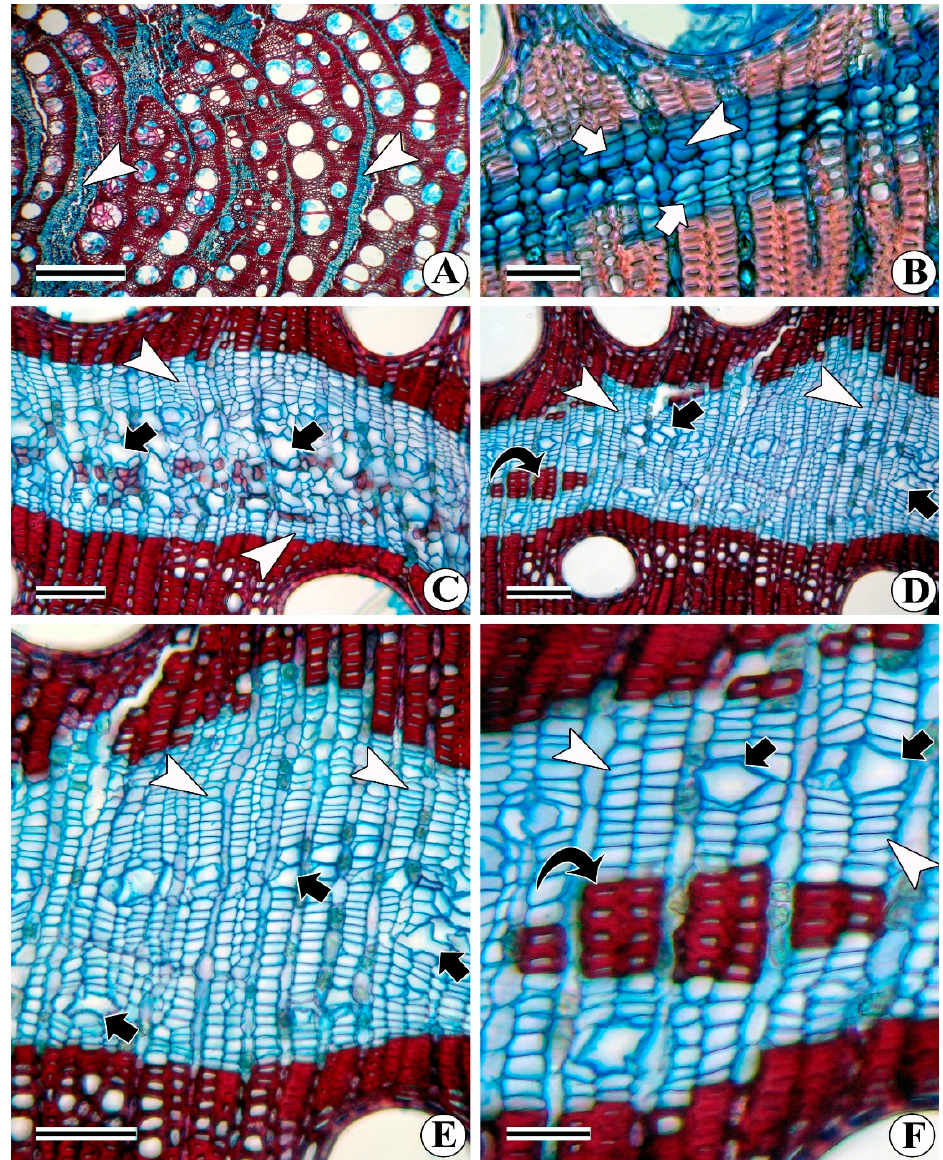
Figure 7. Transverse view of Dalechampia stems showing various stages of interxylary phloem development. ( A ) A mature stem showing tangential bands of unlignified axial parenchyma (arrowheads). Note the radial width of the parenchyma band (left arrowhead). ( B ) Enlarged view of one of the parenchyma bands showing the arrangement of cells (arrows). Note the dividing cell (arrowhead). ( C ) Differentiation of sieve elements (arrows) and separation of cambium (arrowheads) due to the formation of phloem cells. Note the safranin-stained sclerenchymatous cells adjacent to the phloem. ( D ) Several cells wide, radially arranged cambial cells (arrowheads). Note the differentiated phloem (arrows). The curved arrow shows lignified xylem elements. ( E,F ) Enlarged view of Figure 7D showing radial files of cambial cells (arrowheads), phloem elements (arrows), and xylem elements (curved arrow) in Figure 7F. Scale bars: A = 500 µm, B, F = 50 µm; C–E = 100 µm.